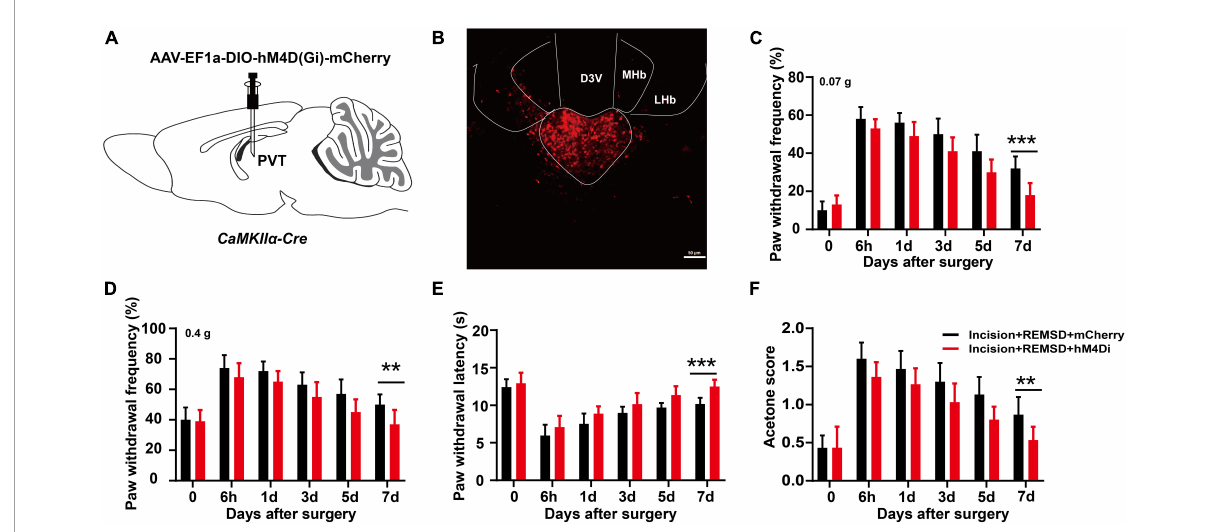
FIGURE6 Chemogenetic inhibition of middle paraventricular thalamus (mPVT) CaMKII α shortened the duration of postsurgical pain induced by rapid eye movement sleep deprivation (REMSD). (A) Experimental configuration showing AAV-EF1a-DIO-hM4D(Gi)-mCherry injection into the mPVT. (B) Representative images of viral expression in the mPVT. (C,D) Mechanical paw withdrawal frequency in response to 0.07 g von Frey (C) and 0.4 g von Frey (D) at different time points. (E) Paw withdrawal latency in response to thermal stimulus at different time points. (F) Measurements of cold sensitivity by acetone testing. Significance was assessed by two-way ANOVA with post hoc multiple comparisons between groups in panels (C–F) . Incision + REMSD + mCherry vs. incision + REMSD + hM4D(Gi) + mCherry; n = 10. ** P < 0.01, *** P < 0.001, scale bar: 50 µ